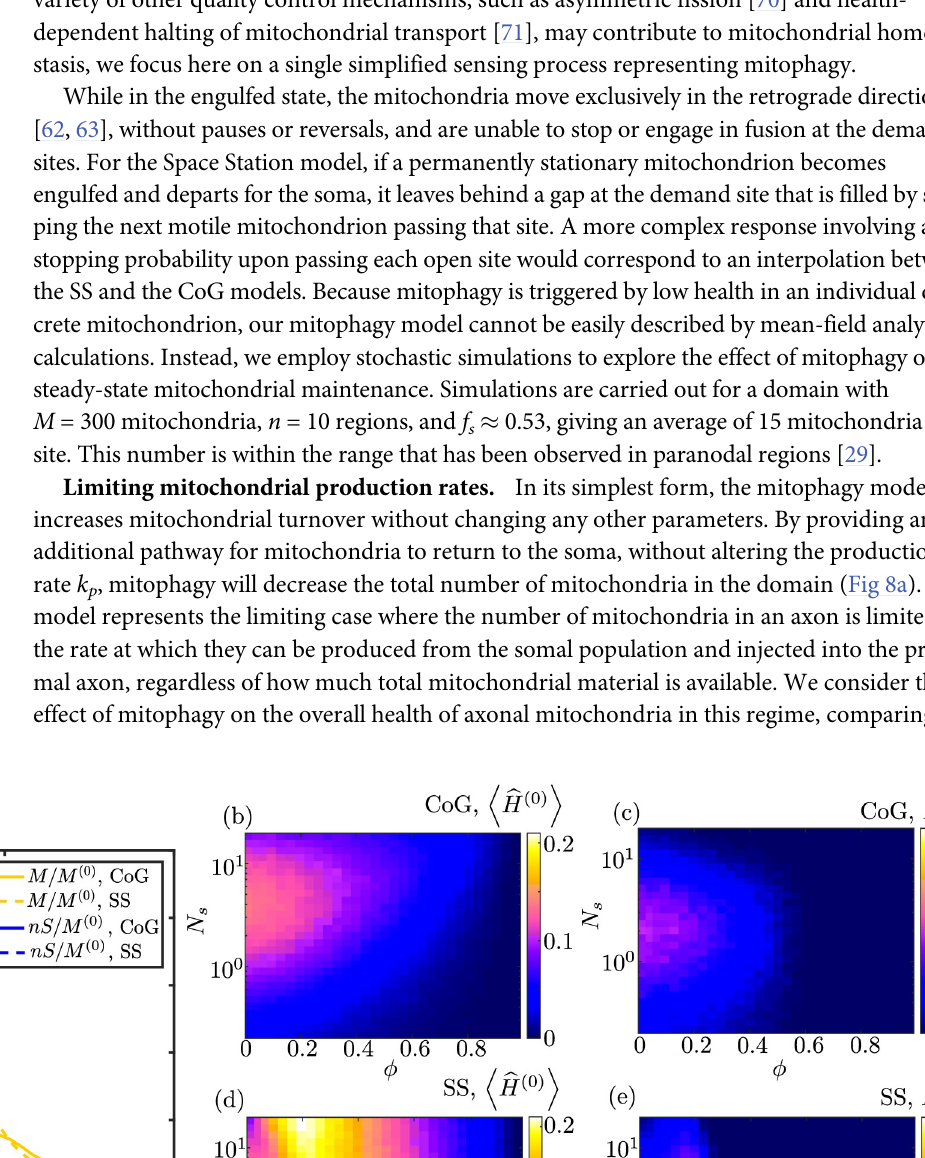
PLOS Computational Biology | https://doi.org/10.1371/journal.pcbi.1009073 June 9,